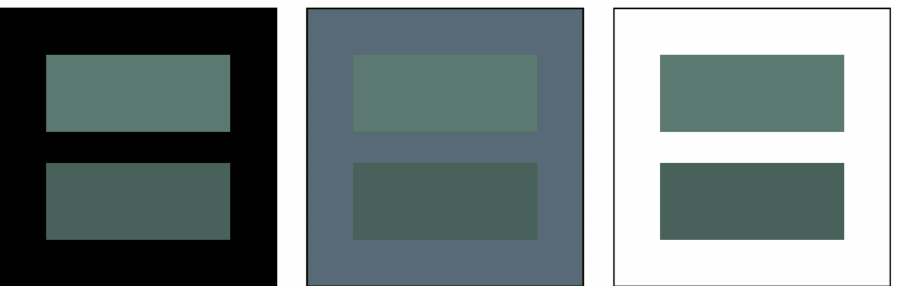
Figure 2. The crispening effect showing that Resnikoff’s assumption about the invariance of color metric with respect to background transformations is not coherent with